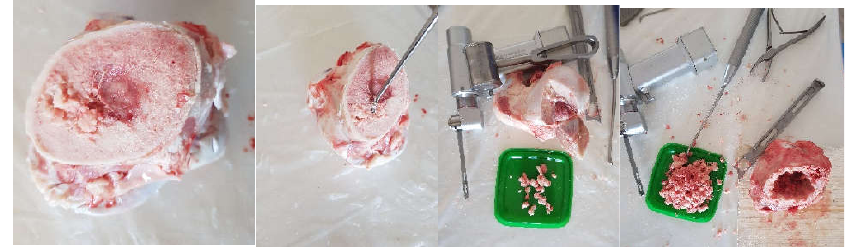
Figure 7. Obtaining the morcellated bone graft.